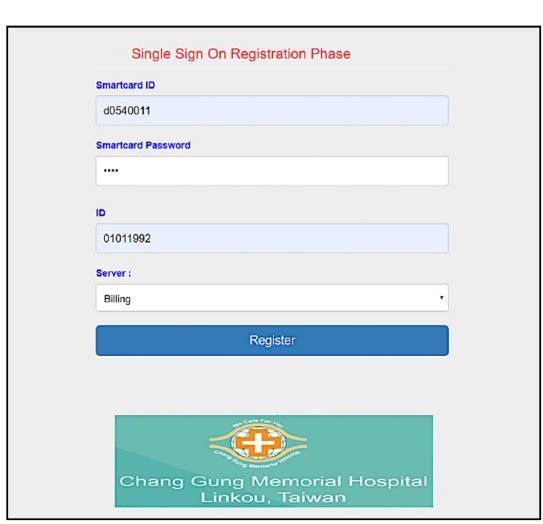
Figure 12. Registration with specific